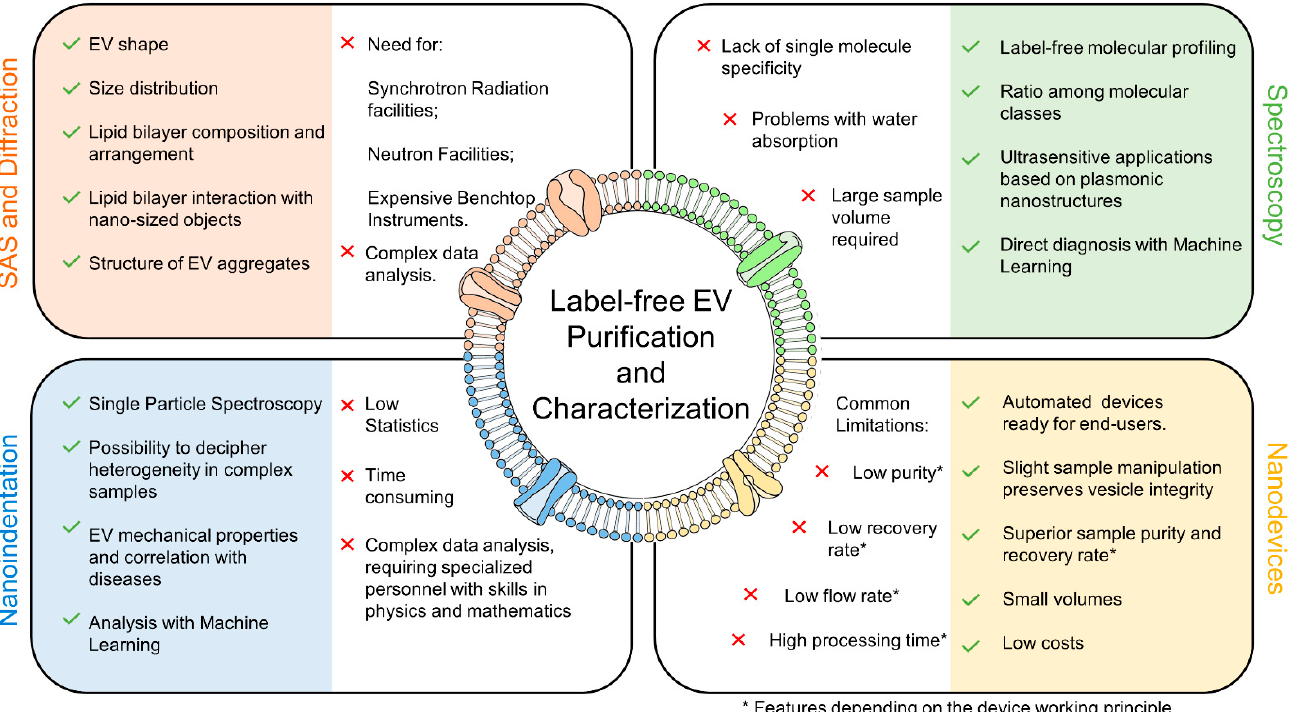
Figure 1. Key characteristics of label-free techniques in EV science.